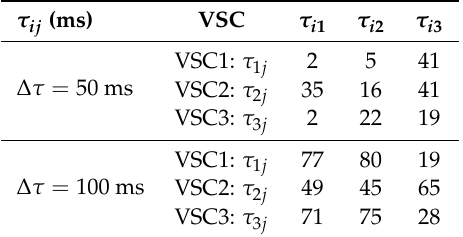
Table 10. Case C. Communication delays used ( τ ij (ms)).